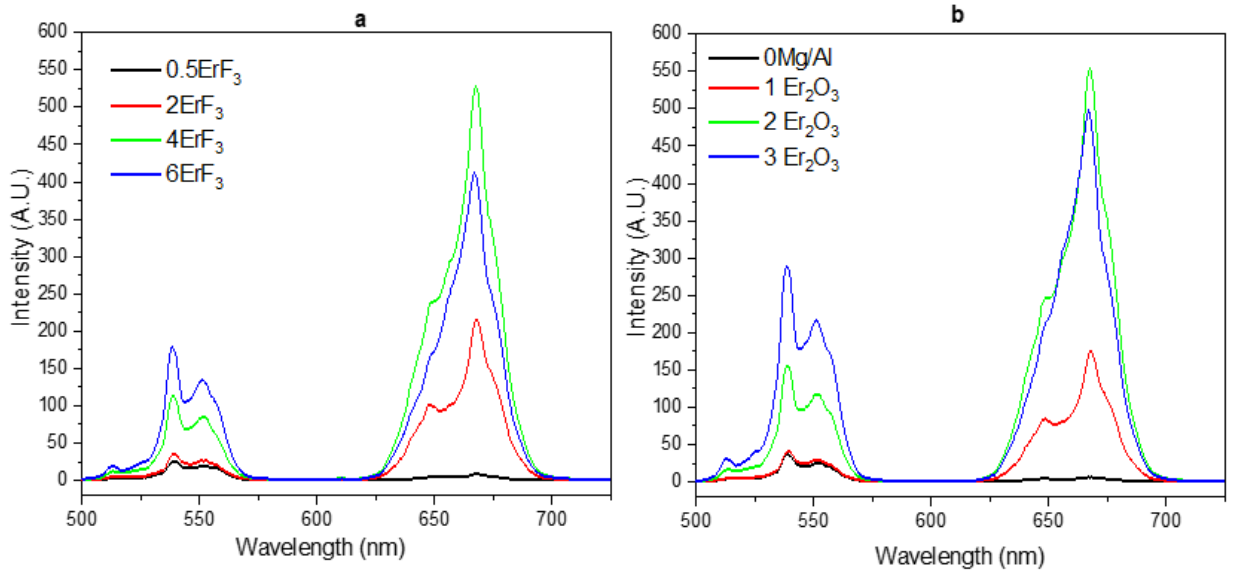
Figure 6. XRD spectra of the glasses prepared with ErF 3 ( a ) and Er 2 O 3 ( b ) after heat-treatment (Tg + 20 ◦ C) for 17 h and at T p for 1 h ( λ exc = 975 nm) [Peaks correspond to * CaF 2 (ICDD PDF #00-035-0816), +NaPO 3 (ICDD PDF#04-011-3120), x Na 2 Ca 2 (P 2 O 7 ) F 2 (ICDD PDF#04-012-1844), o Ca 2 P 2 O 7 (ICDD PDF #00-009-0345)]. Note that the 0Mg/Al corresponds to 0.25Er 2 O 3 glass.